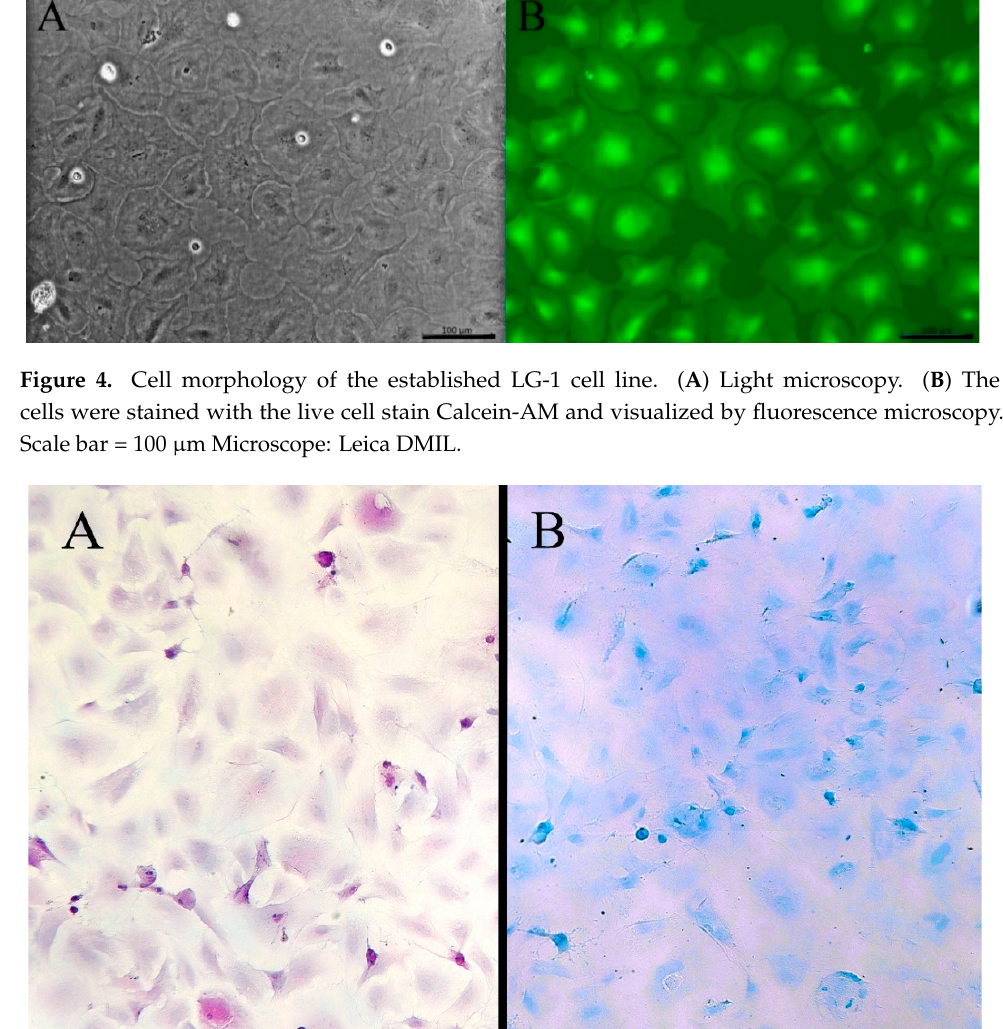
Figure 3. Cell proliferation. The cells were plated at different densities and grown for 1, 7 and 14 days (d) at different temperatures, as indicated. The data are representative of three independent experiments and are expressed as mean ± SD of four parallel incubations. * indicates significantly different from day 1.